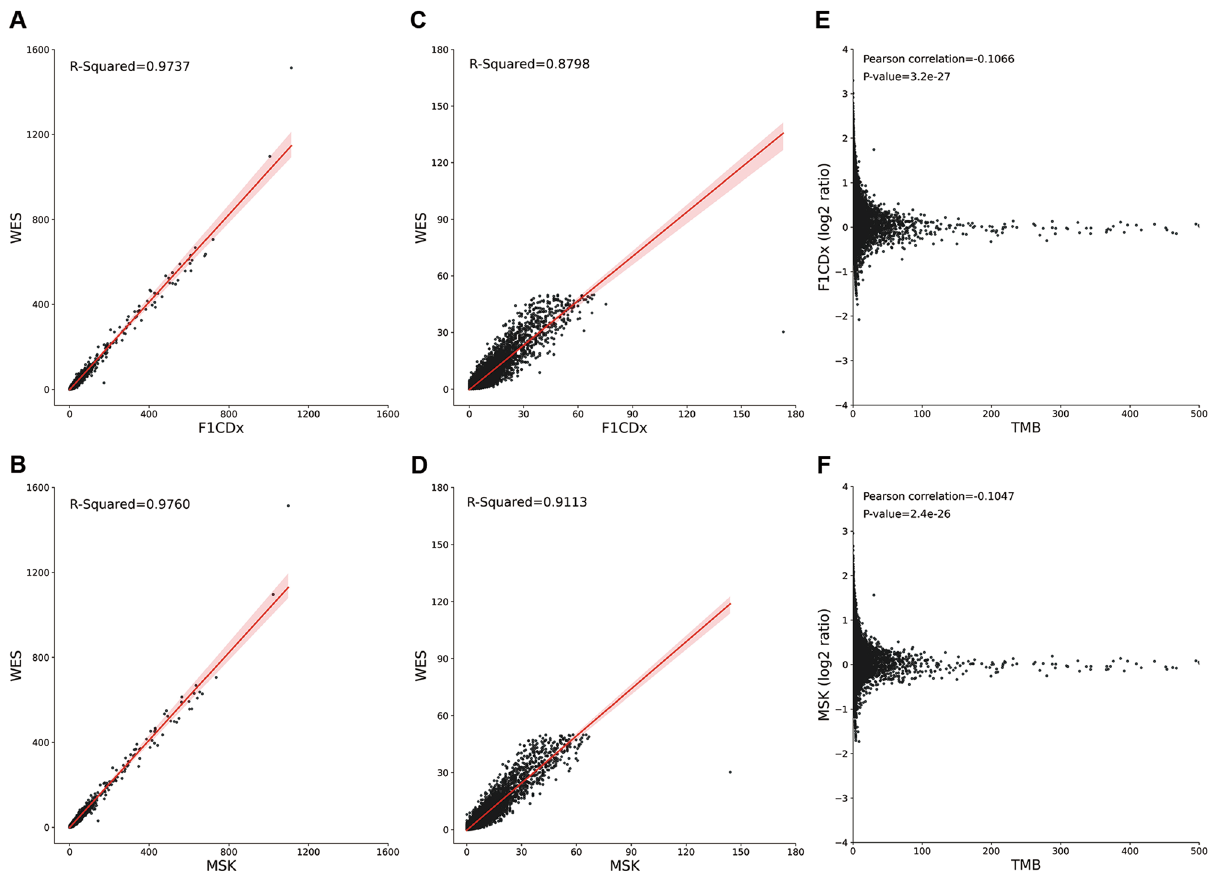
Figure 2. TMB estimation results for gene panels in different datasets. ( A , B ) Linear fit with 95% confidence intervals of panel-based TMB estimated by the F1CDx and the MSK against WES-based TMB in the hypermutation-included dataset. ( C , D ) Linear fit with 95% confidence intervals of panel-based TMB estimated by the F1CDx and the MSK against WES-based TMB in the non-hypermutation dataset. The R-squared values are lower in the non-hypermutation dataset than in the hypermutation-included dataset for both panels. ( E , F ) The correlation between the estimated bias and TMB size (Pearson correlation: F1CDx: − 0.1066, P value: 3.2 × 10 –27 ; MSK: − 0.1047, P value: 2.4 × 10 –26 ). The X axis is the WES-based TMB of the patient and the Y axis is calculated as the panel-based TMB divided by the WES-based TMB. A log-2 scale is used for the Y axis of the graph. Patients with TMB > 500 are not The correlation between panel size and the performance. The rankings of the performance of the seven panels suggested that the performance of a panel may be associated with its panel size. To test our hypoth- esis, we randomly generated 10,000 panels in silico (see Methods) and analyzed the correlation of the two fac- tors. Figure 4A, B display the correlations between the values of the two measurements (R-squared and angular distance) and panel size for the 10,000 simulated panels. With the increase in panel size, R-squared increases and angular distance decreases, indicating that panel size is an important factor to improve the accurate of TMB estimation, which is consistent with previous studies 27,28 . Comparing the changes in R-squared to the changes in angular distance with the increase in panel size, R-squared increases quickly and reaches a plateau after the panel size reaches 0.5 Mb. However, the angular distance of the panels shows that the estimated bias is still high when panel size is 0.5 Mb. Indeed, the angular distance is still sensitive to the changes in panel sizes when the panel size reaches 6 Mb. In addition, for most panels, their R-squared values between the hypermutation-included dataset and the non-hypermutation dataset are extensively different (Fig. 4A), but their angular distances between the two datasets are close (Fig. 4B). Moreover, by comparing the average angular distance of the 10,000 simulated panels to the real TMB of each patient, we find that their average angular distance is negatively correlated with their TMB (Fig. 4C). Therefore, for patients with higher TMBs, a smaller panel size sufficiently conforms to the estimation, while for patients with lower TMBs, a larger panel size is needed. One of the major applications of TMB is that it is a biomarker for predicting ICB outcomes. In the study of CM026 trail, PFS and objective response rate (ORR) were significantly higher with nivolumab than with chemo- therapy when the missense mutation count of the patient was no less than 243 15 . A similar study demonstrated that the PFS of patients whose TMB ≥ 10 mutations/Mb was significantly longer when using immunotherapy than chemotherapy 29 . Following the recent FDA approval of a 10 mutations/Mb threshold to select patients for ICB therapy, accurately estimating the patients with TMB ≈10 mutations/Mb is extremely important. To this end,